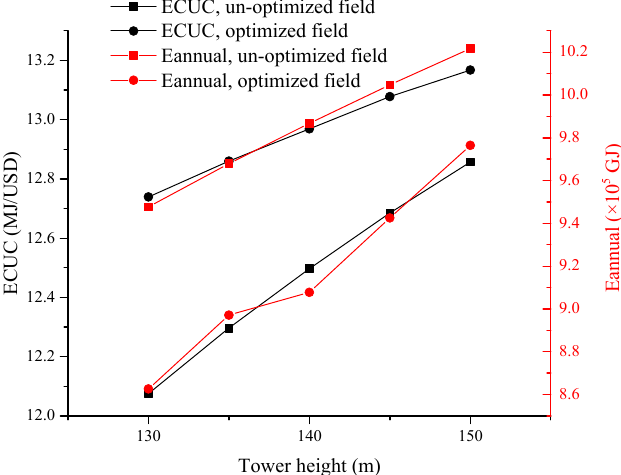
Figure 7. Effect of tower height on the energy collected of unit cost and annual energy collected.